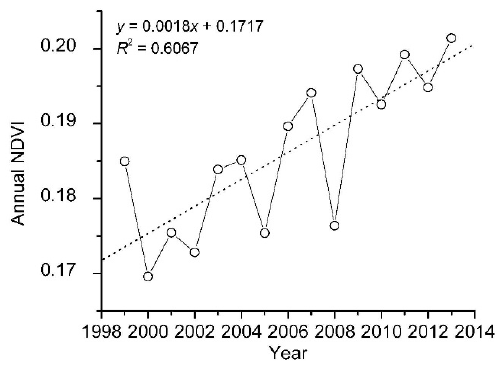
Figure 2. Changes of annual NDVI in the YZR basin from 1999 to 2013.